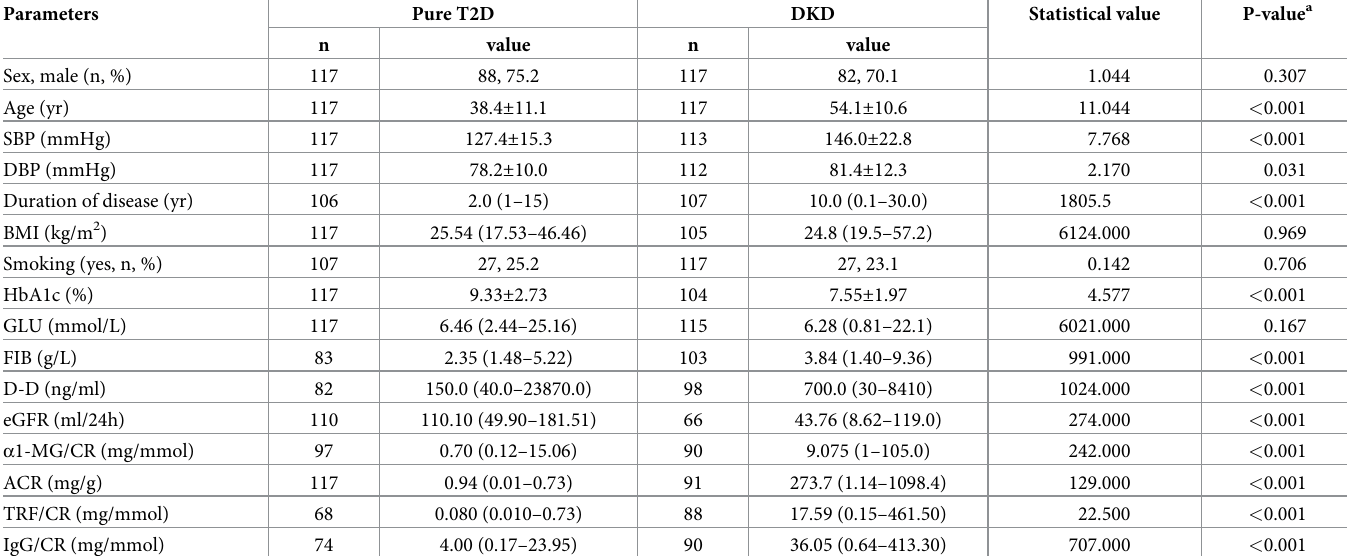
Table 1. Comparisons of clinical and laboratory characteristics of pure T2D and DKD